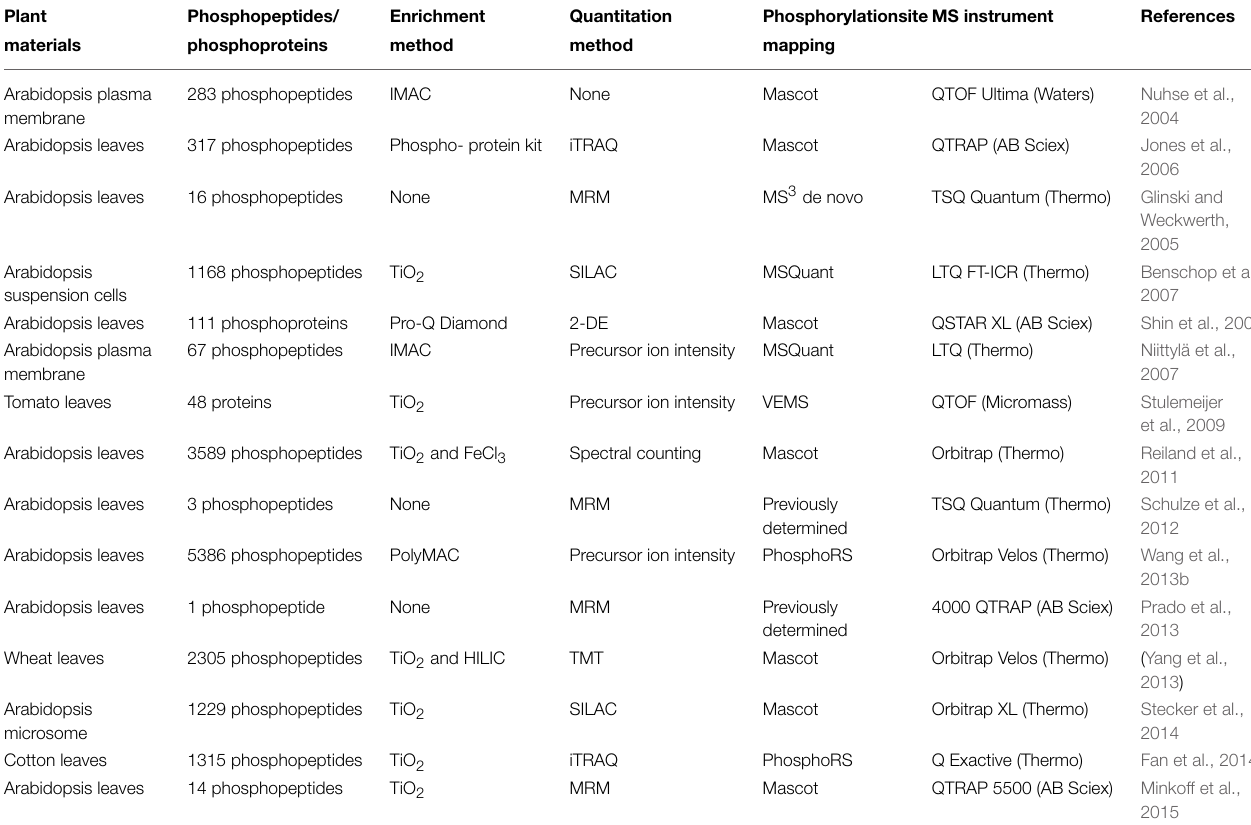
TABLE 2 | Representative plant phosphoproteomics work in the past decade.